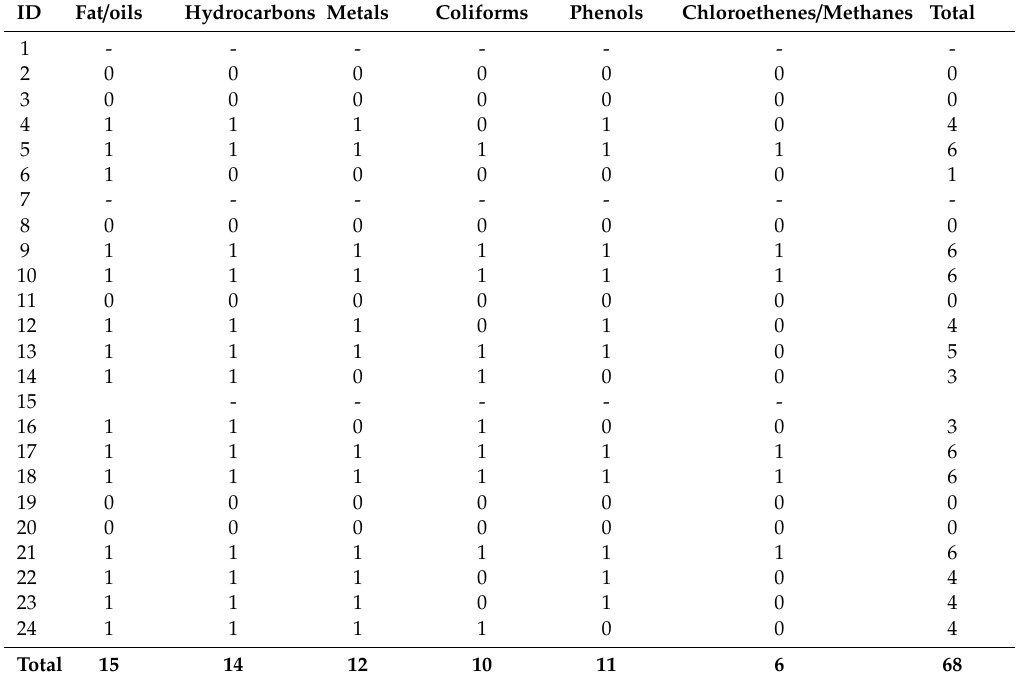
Table A1. Irrelevant descriptors identified in the e ffl uent monitoring.